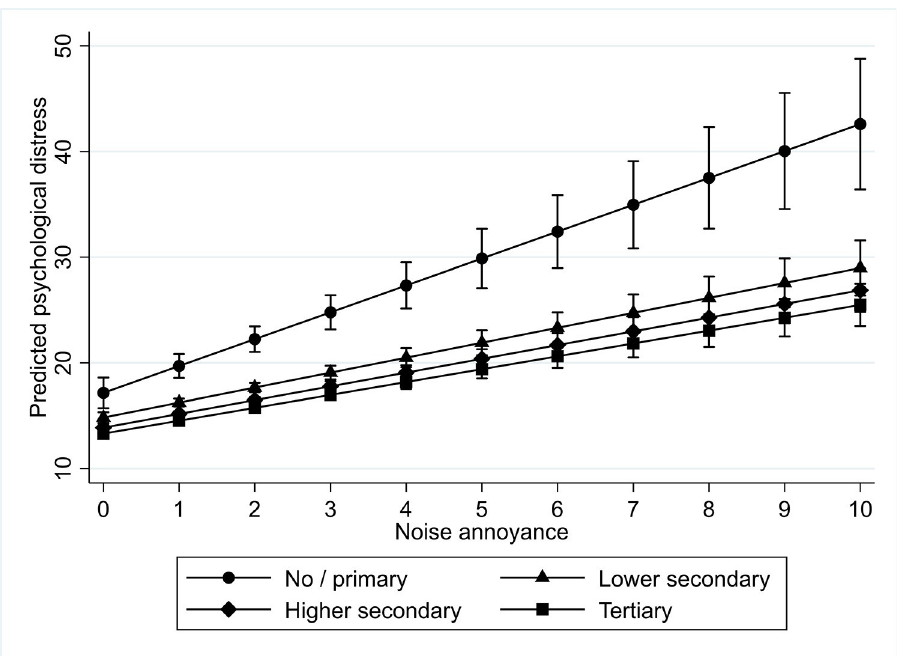
Fig 2. Interaction plot for predicted psychological distress among different educational levels by level of noise annoyance.